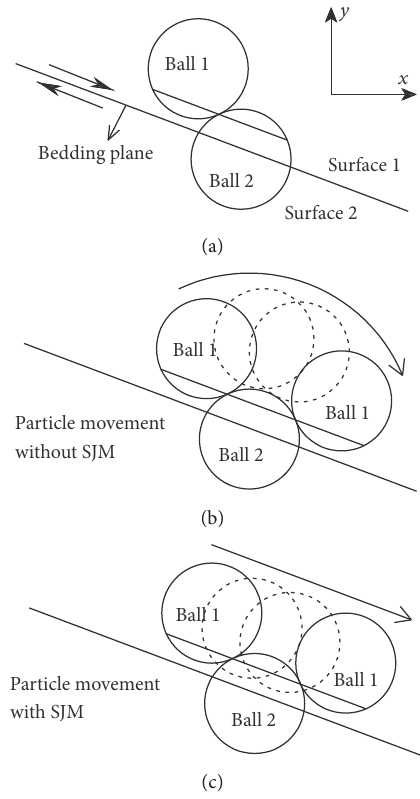
Figure 2: Particle movement at the bedding